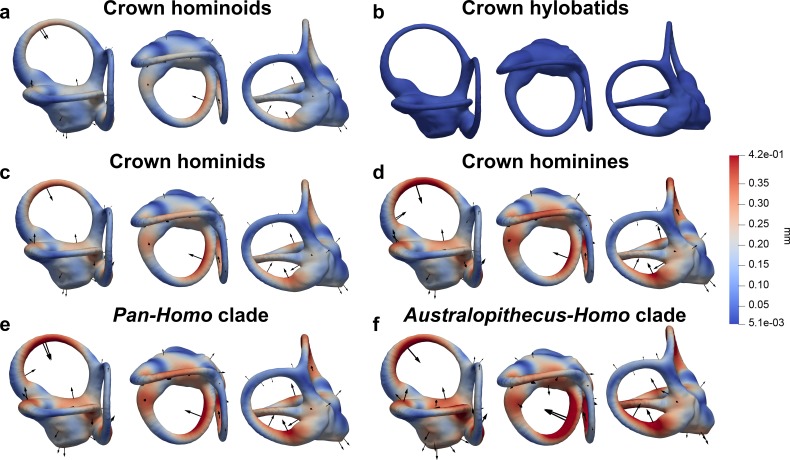
Reconstructed vestibular shape for the last common ancestors (LCA) of the main clades of interest as reconstructed using maximum likelihood methods for deformation-based 3DGM analyses applied to the anthropoid sample (Figure 7), in lateral (left), superior (middle), and posterior (right) views.Cumulative displacement variations are rendered by pseudocolor scale ranging from dark blue (<5.1 µm) to dark red (0.42 mm). Black arrows correspond to the vectors identifying the direction of displacement. The reconstructed LCAs depicted are the following: (a) crown hominoids; (b) crown hylobatids; (c) crown hominids; (d) crown hominines; (e) Pan-Homo clade; (f) Australopithecus-Homo clade.